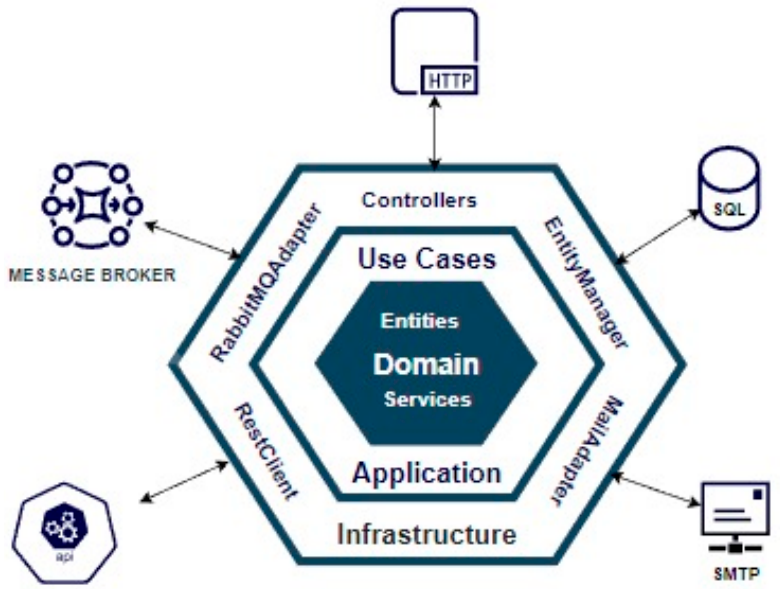
Figure 1. Hexagonal